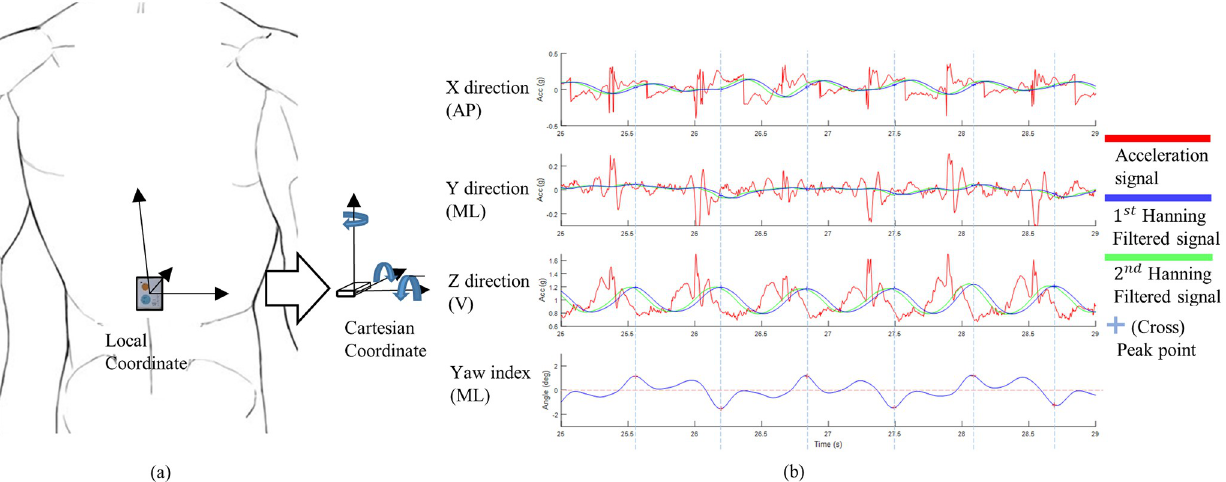
Fig 1. Acquisition and preprocessing of the signals from a wearable inertia sensor. (a) Three-dimensional acceleration signals were acquired from an inertia sensor placed at the center of body mass and re-oriented into Cartesian coordinates to correct the angular misplacement. (b) Hanning filter was applied to the raw acceleration signals and then each step was identified (indicated by crosses). The sides of steps (left or right) were determined by the yaw index at each step.